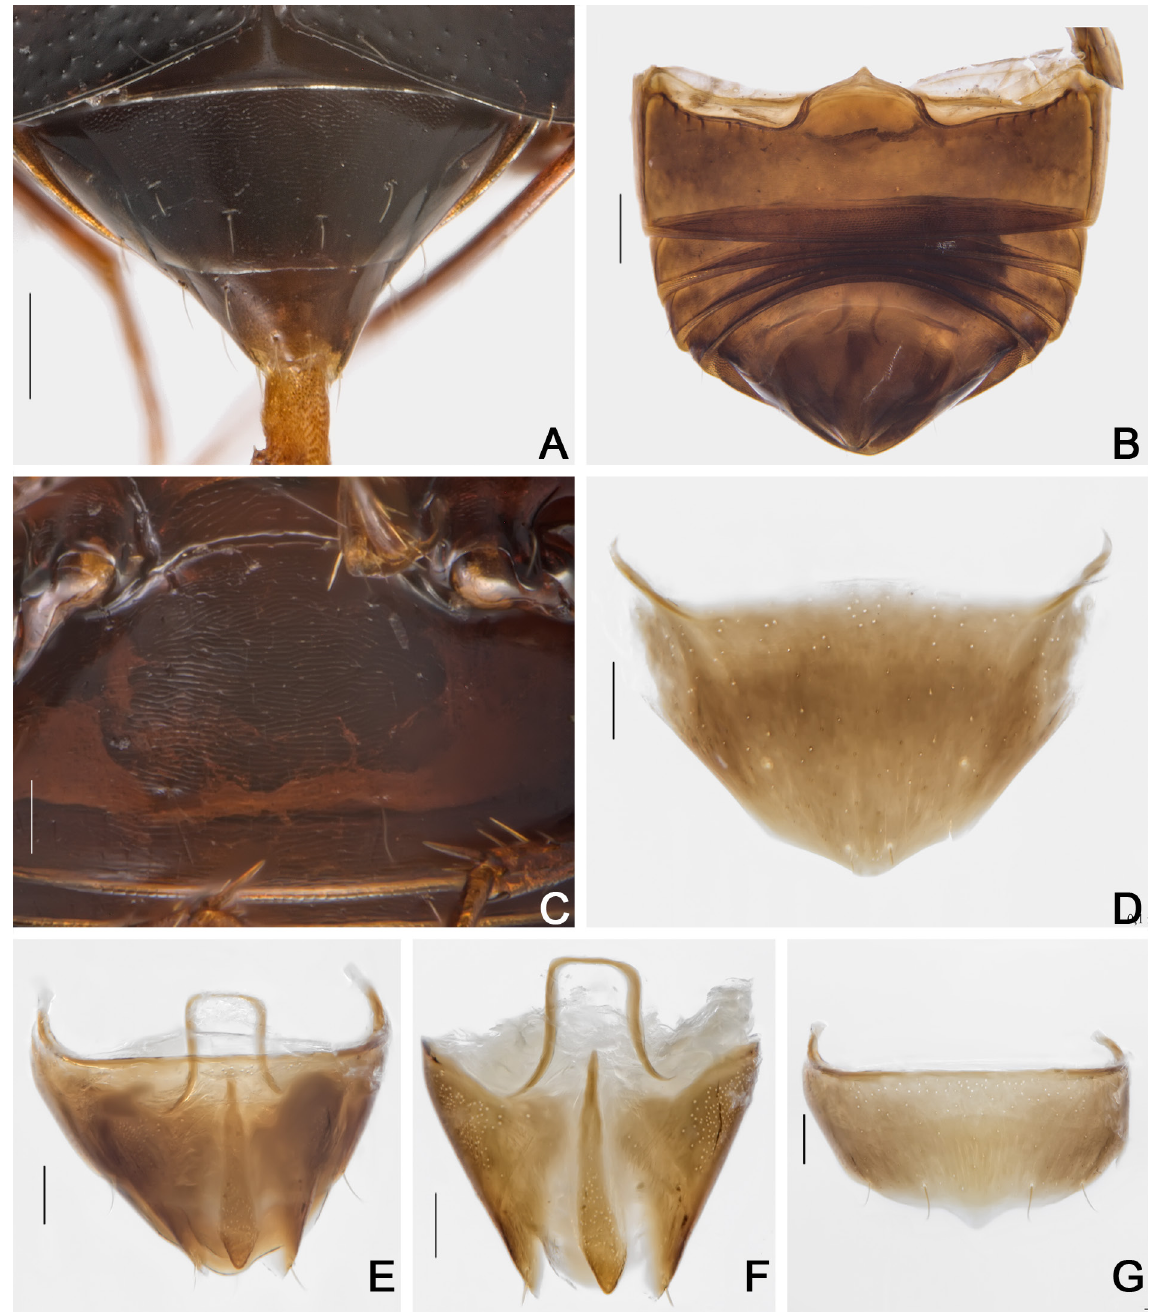
Fig. 19. Cyparium lescheni sp. nov. A–C . Holotype, ♂ (CELC). D–G . Paratype ♂ (CELC). A . Abdomen, dorsal view. B . Abdomen, ventral view. C . Ventrite 1. D . Tergite VIII. E . Terminalia. F . Tergite IX. G . Sternite VIII. Specimens collected at Mata do Paraíso, Viçosa (A–C) and Mata da Biologia (D–G), Viçosa (MG, Brazil). Scale bars: A–B = 0.2 mm; C–G = 0.1